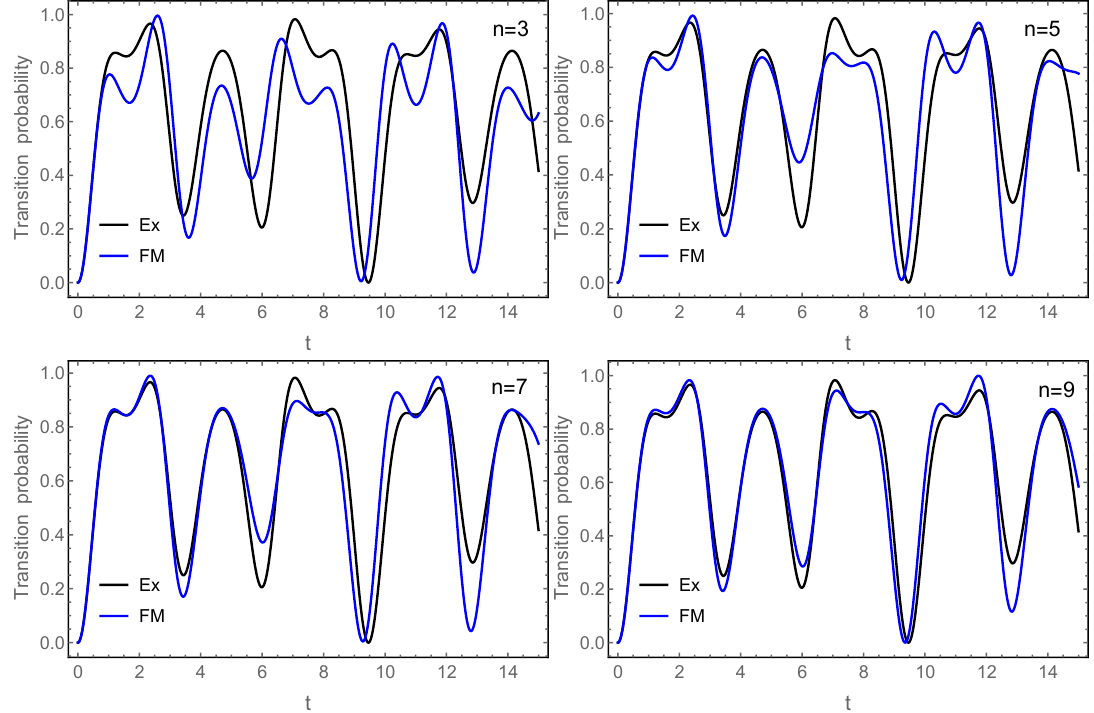
Figure 7. Transition probability obtained with FM (solid blue line) with n = 3,5,7,9 terms (left to right, top to bottom) in comparison with the exact result (black line) for the Bloch–Siegert Hamiltonian with ε = 1.5.